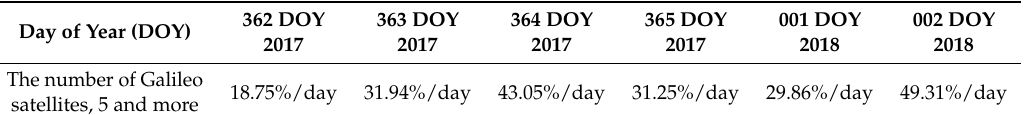
Table 7. Visibility time of at least 5 Galileo satellites, within 24 h, at the elevation >10 ◦